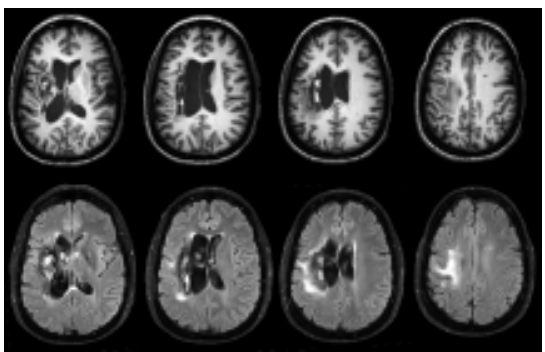
Fig. 1. The stroke involved the left putamen and the arcuate fascicu- lus resulting in severe Broca’s aphasia characterized by the labored production of single words with poor